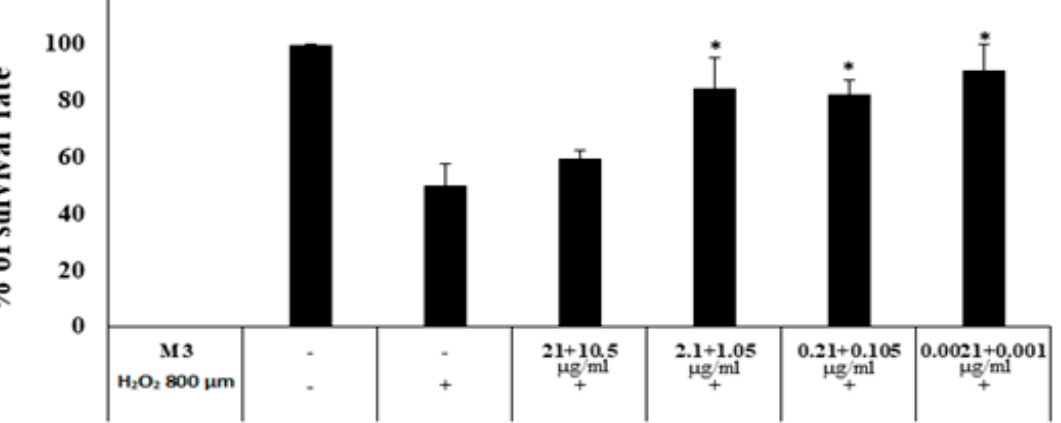
Figure 8. Antioxidant effect of formula M3 (AA + CAFF) on H 2 O 2 induced oxidative stress in MCF-7 cells (Means + S.D.). * p < 0.05 compared with H 2 O 2 only treated group.